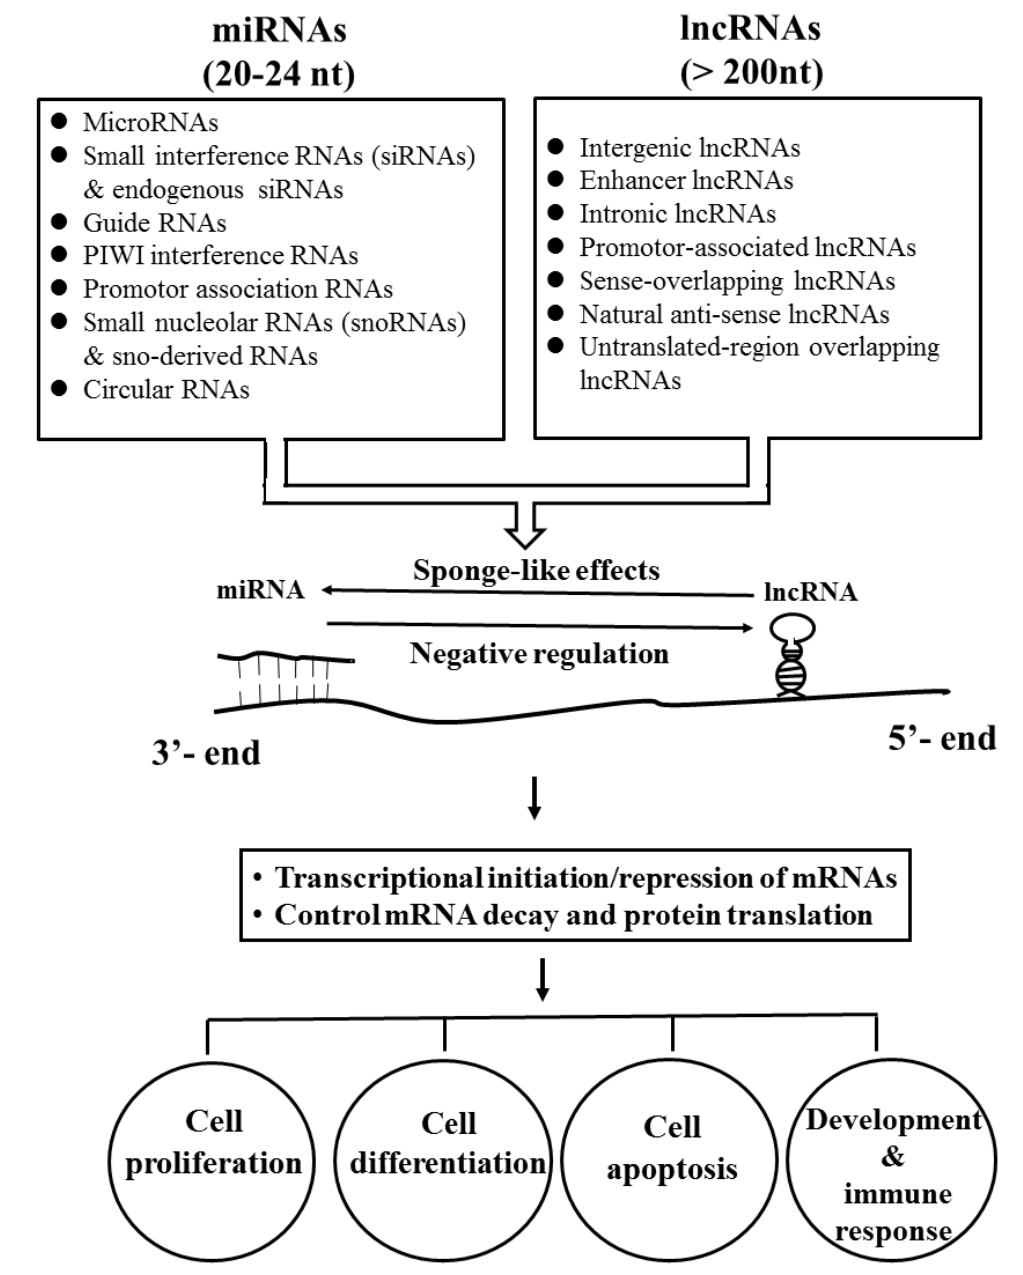
Figure 2. Different types of microRNAs (miRNAs) and long non-coding RNAs (lncRNAs) with their mutual interactions on the post-transcriptional regulation of mRNA expression and cell functions including proliferation, differentiation, apoptosis, and development of immune responses.